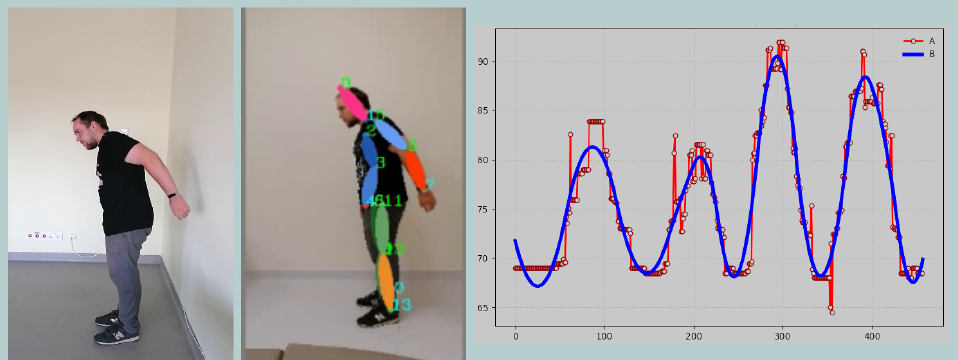
Figure 3. A snapshot of the application window showing live view ( left ), skeleton keypoints ( middle ), and dynamic data view ( right